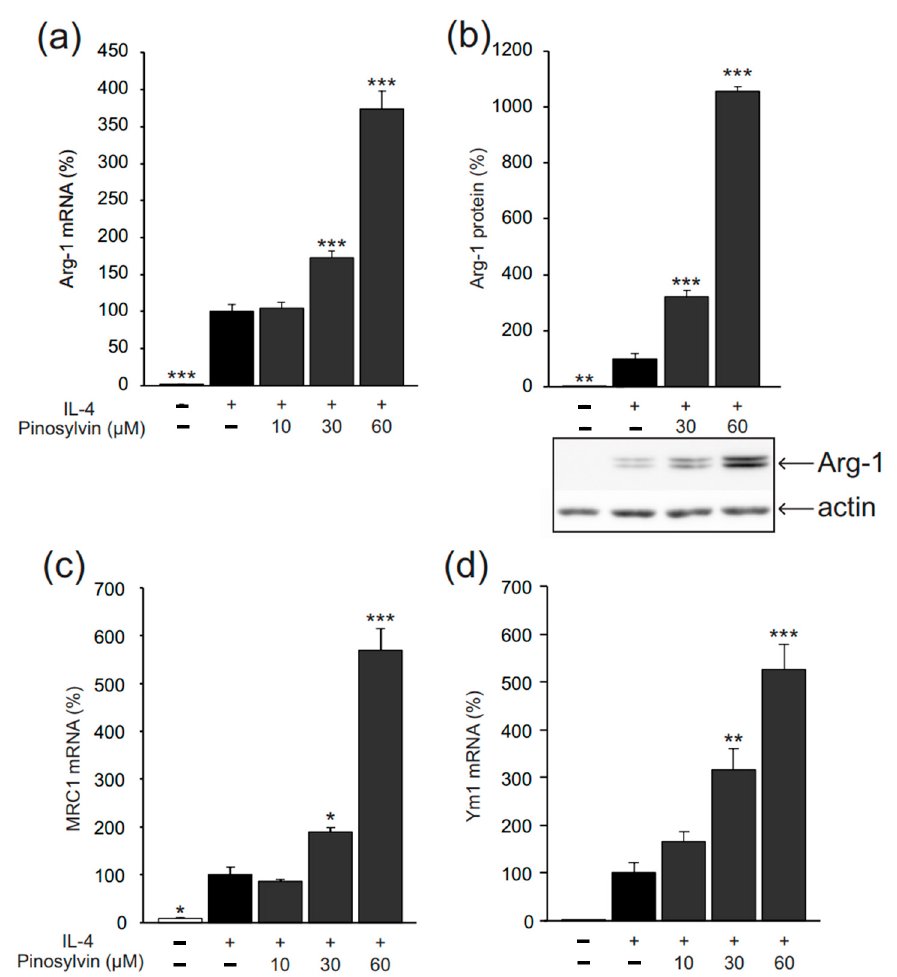
Figure 2. Pinosylvin enhanced IL-4-stimulated expression of markers of alternative (M2-type) macrophage activation in J774 murine macrophages. J774 cells were cultured with IL-4 (10 ng/mL) alone, or together with pinosylvin for 24 h ( a – c ) or 8 h ( d ). Expressions of arginase-1 (Arg-1), mannose receptor C type 1 (MRC1), and chitinase-3-like 3 (Ym1) mRNA were measured by quantitative reverse transcriptase polymerase chain reaction (qRT-PCR) and normalized against GAPDH mRNA ( a , c , d ). Arg-1 protein was measured with Western blot using actin as a loading control ( b ). The results are expressed as mean + SEM, n = 6 ( a , c ) or n = 4 ( b , d ). Statistical significance of the results was calculated by one-way ANOVA followed by Bonferroni multiple comparisons test. * = p < 0.05, ** = p < 0.01, and *** = p < 0.001 as compared to cells cultured with IL-4 only, marked as a black bar.